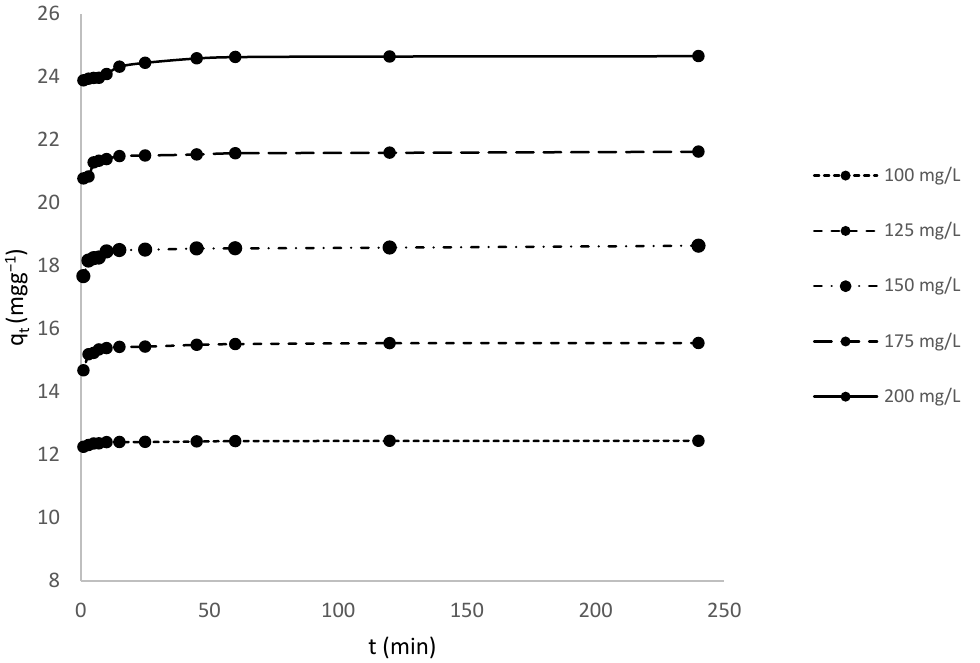
Figure 2 . Effect of pH on adsorption of MV onto HNC . Figure 2. Effect of pH on adsorption of MV onto HNC.